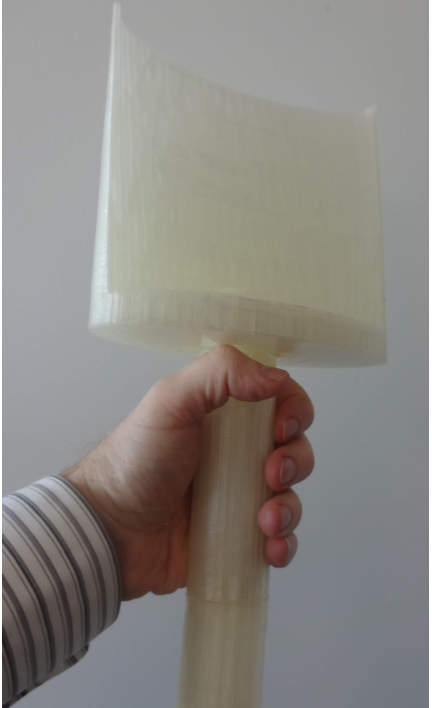
Figure 4. 3-D printable shovel with handle components that fit together to extend the reach to the necessary